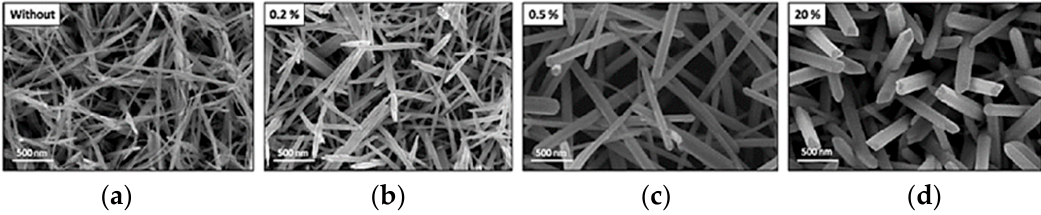
Figure 8. SEM images of Te nanostructures electrodeposited at C1 peak potential (varies from − 0.58 V to − 0.67 V vs. Ag I /Ag) in pure [EOPip][Tf 2 N] ( a ) without and three [EOPip][Tf 2 N]:[EOPip]Br melts (mol%): ( b ) 0.2%, ( c ) 0.5% and ( d ) 20%. [TeCl 4 ] = 5 mM. T = 100 °C, Q = 2C/cm 2 , Pt-coated glass